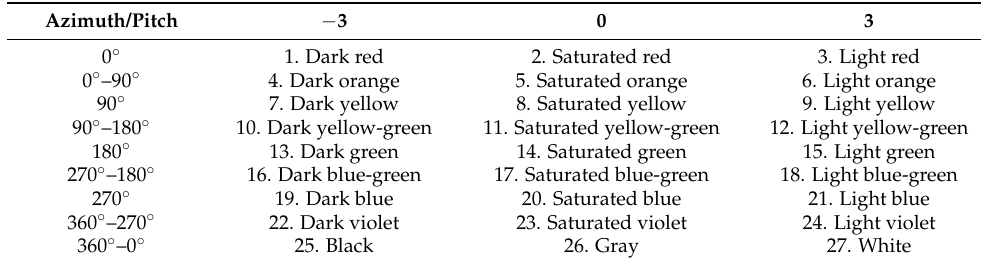
Table 3. Sound representations of 8-color wheel